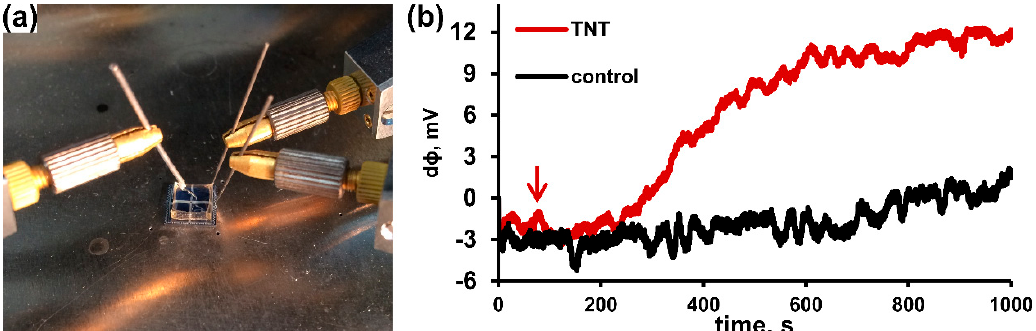
Figure 6. The ion-selective field effect transistor (ISFET) with a well-like structure during the experiments ( a ). Real-time signal of the ISFET modified with nitroreductase after the addition of trinitrotoluene (indicated by the red arrow) ( b ).